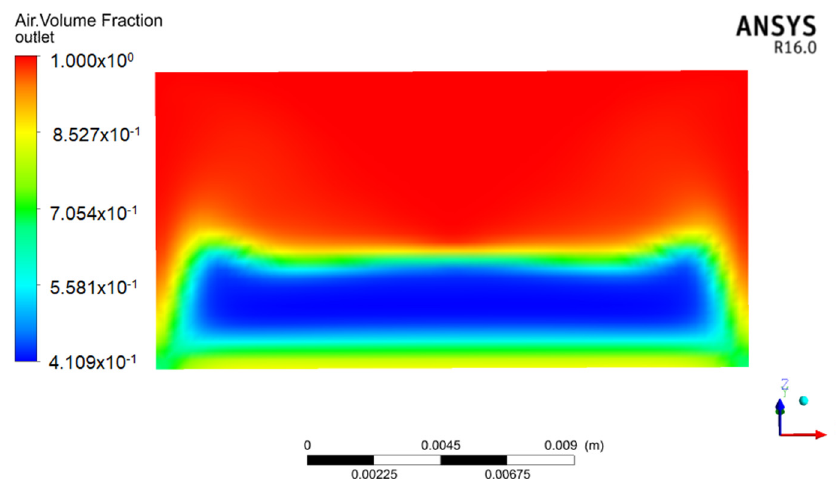
Figure 8. Air volume fraction at the outlet.